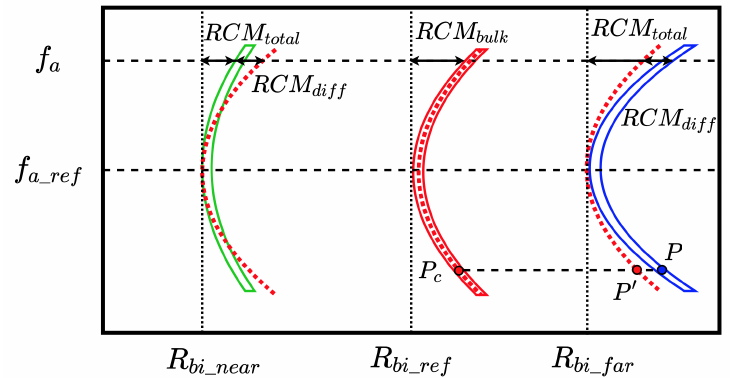
Figure 8. The range variance curves in RD domain. The vertical and horizontal directions of Figure 8 are defined as the azimuth frequency and the bistatic range gate, in accordance with the definitions in Figure 5. The horizontal dashed line f a and f a _ ref are the Doppler frequency and azimuth reference frequency, the vertical black dotted lines represent the near R bi _ near , middle R bi _ ref , and far R bi _ far bistatic ranges. The solid green, red, and blue curves are utilized to express the RCMs of targets located in the near, middle and far bistatic range gates, respectively. The three red dotted curves represent the RCMs of targets located in the middle bistatic range gate. By shifting the red dotted curve to the near and far range gates, we distinguish the range variance characteristics visually. We assume the distance from vertical black dotted lines to the responding solid curves as RCM total . The distance from vertical black dotted lines to the red dotted curves is supposed as RCM bulk . The difference between RCM total and RCM bulk is defined as RCM dif f . According to Equation (21) in Section 2, we obtain the different RCM expressions as Equation (28). Take P as an example (the blue point in Figure 8), P is located in the far bistatic range curve. P c is located in the middle bistatic range curve. Connect P c with P , the black dashed line P c - P intersects the red dotted curve at P (cid:48) . If we can shift P to P (cid:48) to complete the range variance removal, the middle and far curves